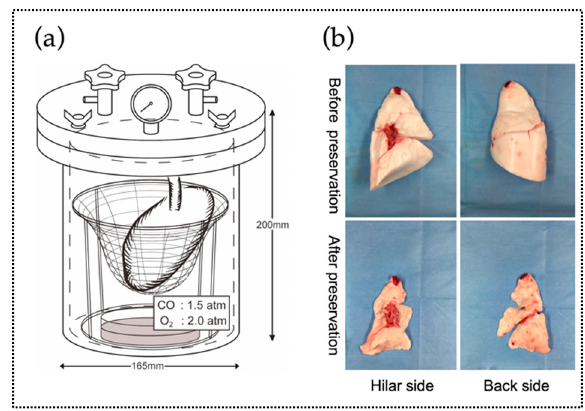
Figure 4. Schematic representation of the preservation method used in this study (Experiment 2).